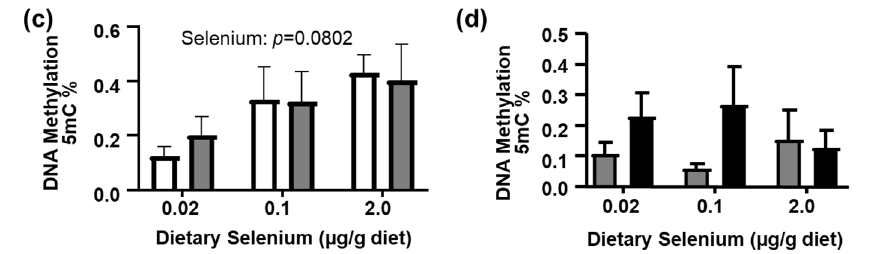
Figure 2. Hepatic AOM-metabolism. Catalytic activity of CYP2E1 in hepatic microsomes was affected by dietary selenium levels, but not by the Selenof genotype in ( a ) untreated or ( b ) AOM/DSS treated animals. ( c ) Global 5-mC DNA methylation in liver increased with dietary selenium in control animals. ( d ) AOM/DSS-treated animals displayed greater variability, but no statistically significant differences. Mean (N = 4–8) + SEM, analyzed by 2-way ANOVA, followed by Tukey’s post hoc analyses.